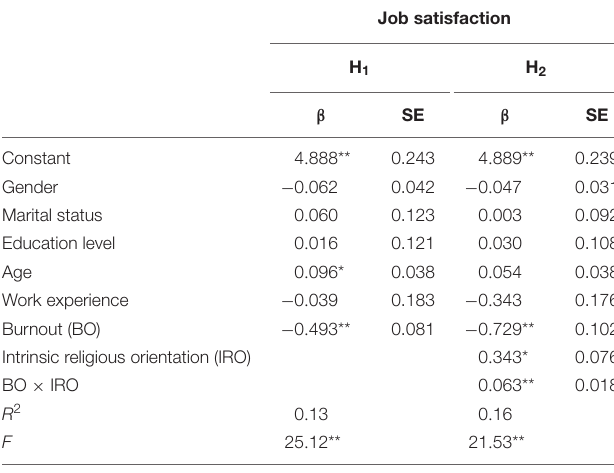
TABLE 2 | Intrinsic religious orientation (IRO) moderating